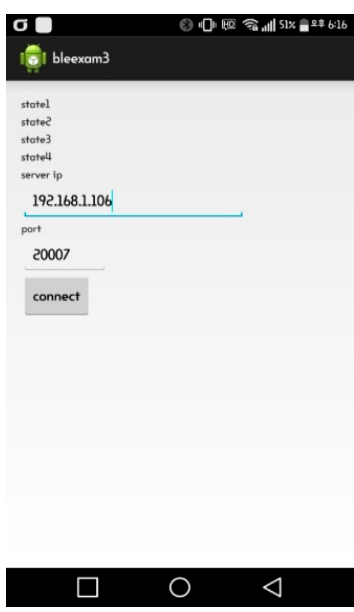
Figure 10. Execution of User Application (Scenario 1).